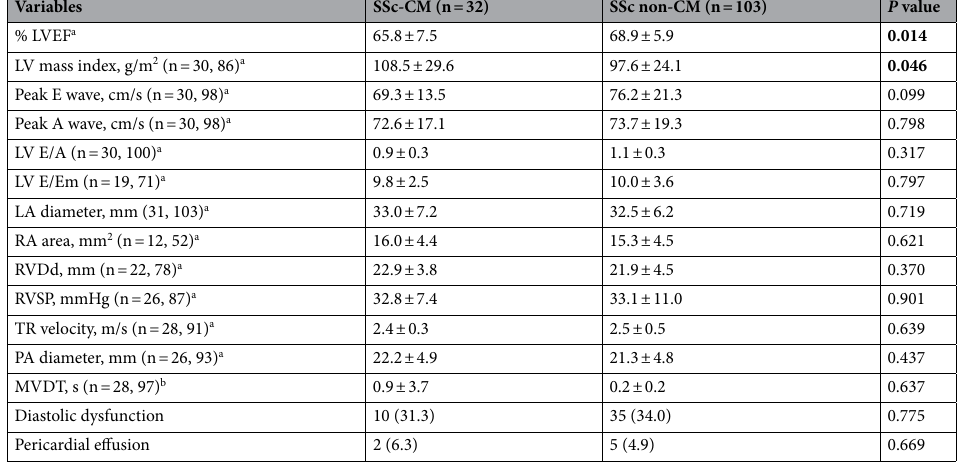
Table 2. Echocardiographic findings between early SSc-CM and non-CM at study entry. Values are presented as mean ± SD, or n (%). LVEF left ventricular ejection fraction, E wave , early diastolic transmitral velocity, A wave , atrial filling transmitral velocity, LA Left atrial, RA Right atrial, RVDd Right ventricular dimension at end-diastole, RVSP Right ventricular systolic pressure, TR velocity, tricuspid regurgitation velocity, PA